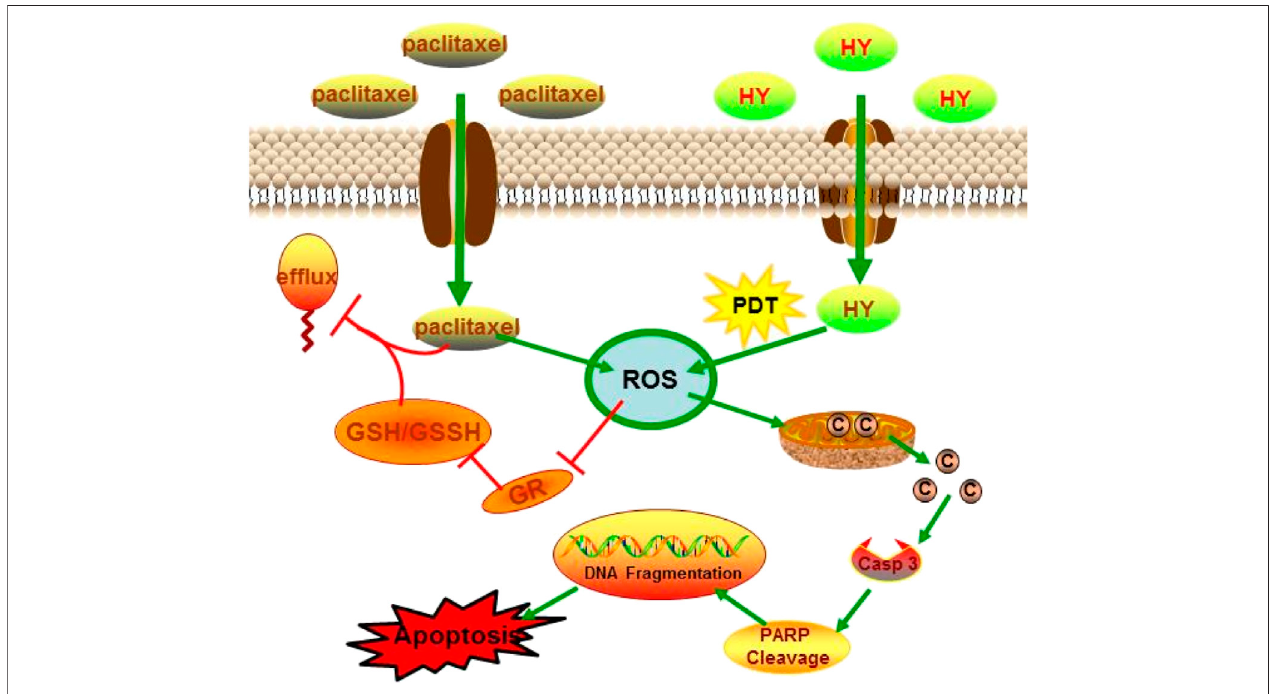
FIGURE 7 | Schedule of HY-PDT combined with paclitaxel enhanced apoptosis in B16-F10.